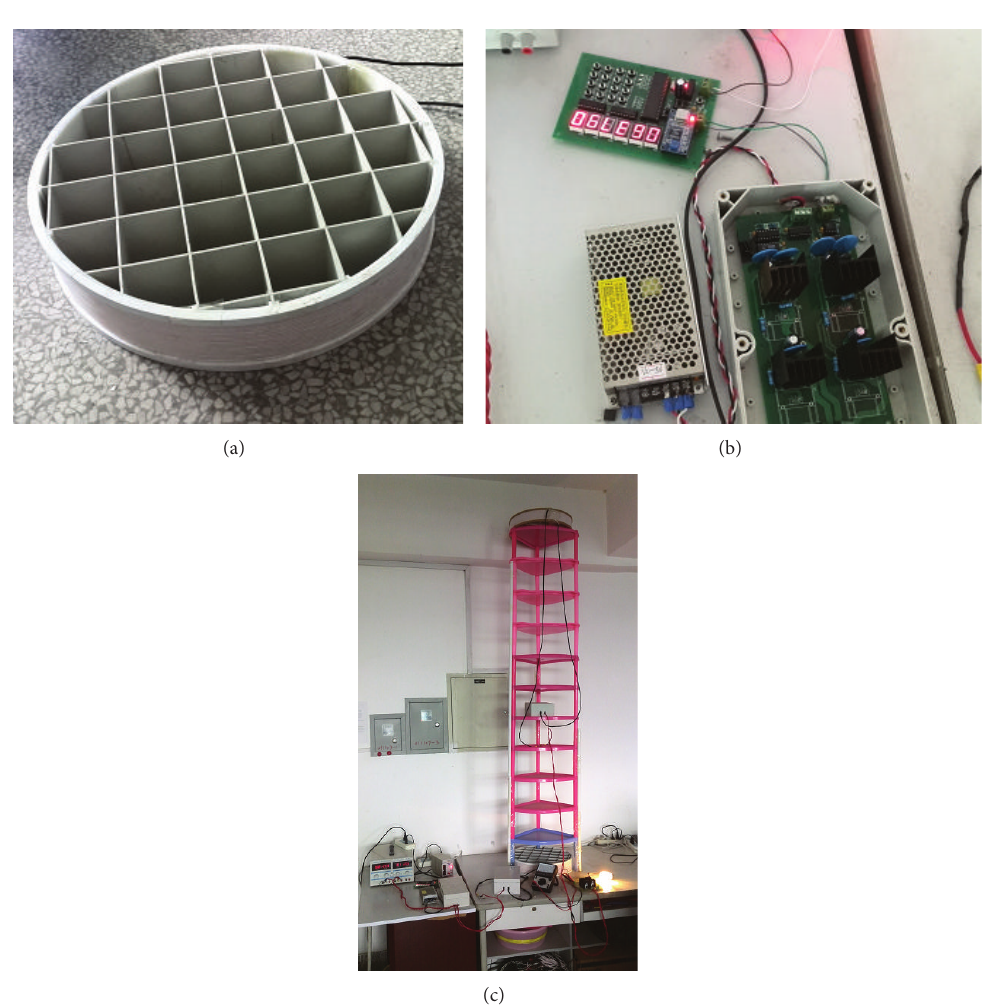
Figure 8: Picture of the WPT system. (a) Coil structure. (b) Power electronics. (c) Test